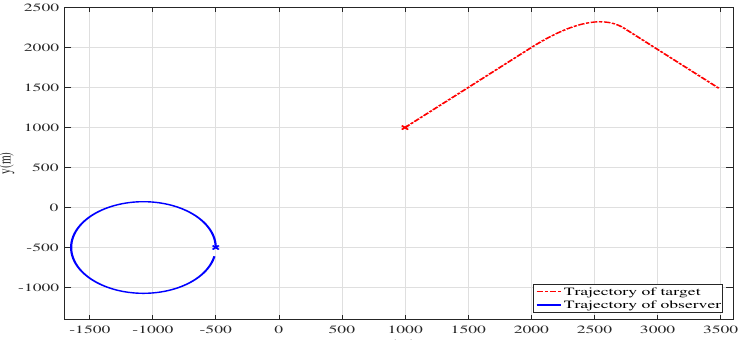
Figure 4. Geometry for scenario 2. The red curve represents the target trajectory while the observer trajectory is given by the blue curve.